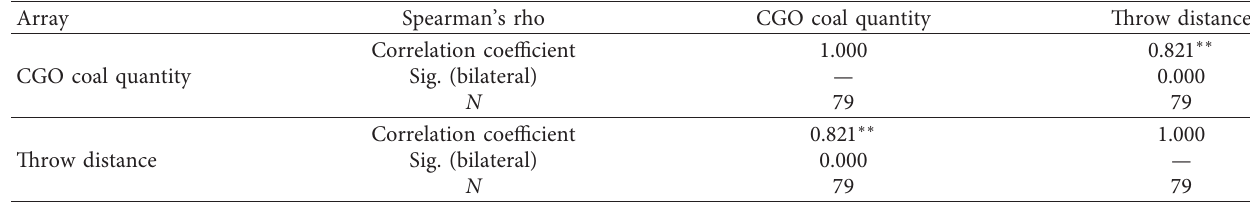
Figure 4: 3D scatter diagram of buried depth, coal volume, and throwing distance and its projection on three planes. Table 4: Correlation between CGO coal quantity and throw distance.